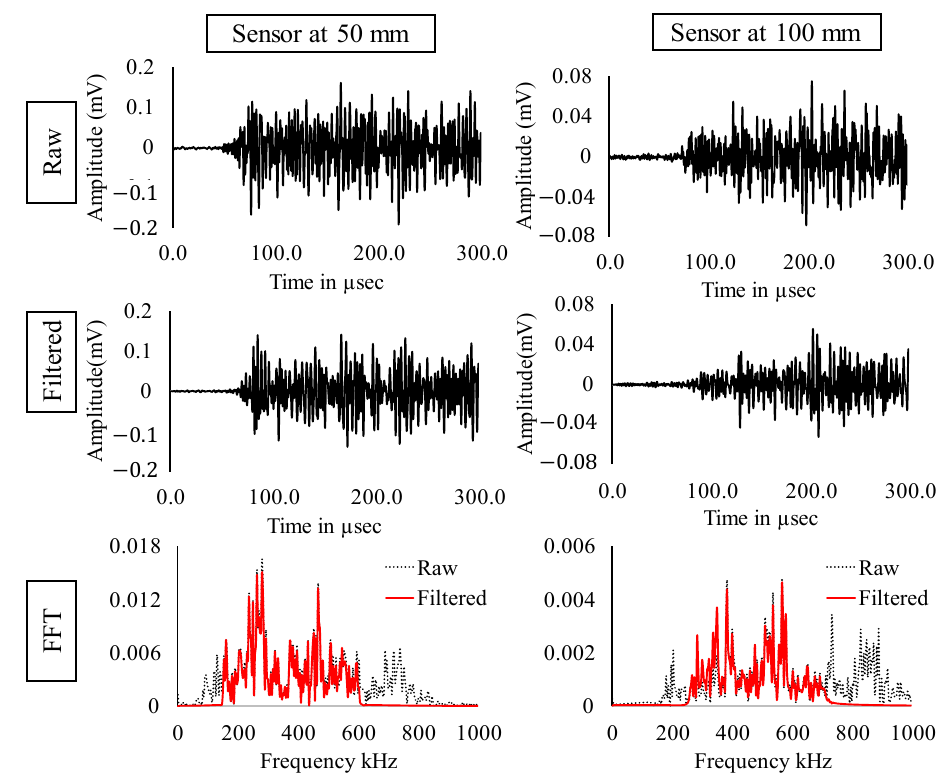
Figure 13. Raw, filtered and FFT of AE signals occurring at load = 100 kN.